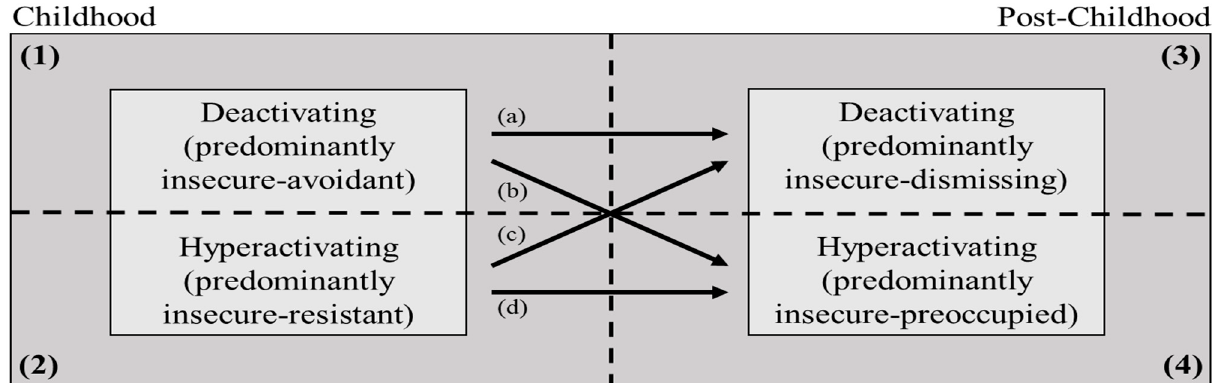
Figure 1. Suggested study design to test the mis/match hypothesis in the context of insecure attachment and internalizing symptoms across the lifespan. Four groups (a–d) that differ in their insecure attachment dis/continuity between childhood to post-childhood developmental periods will be assessed. Each quadrant (1–4) represents an interaction of an insecure attachment pattern and developmental period.